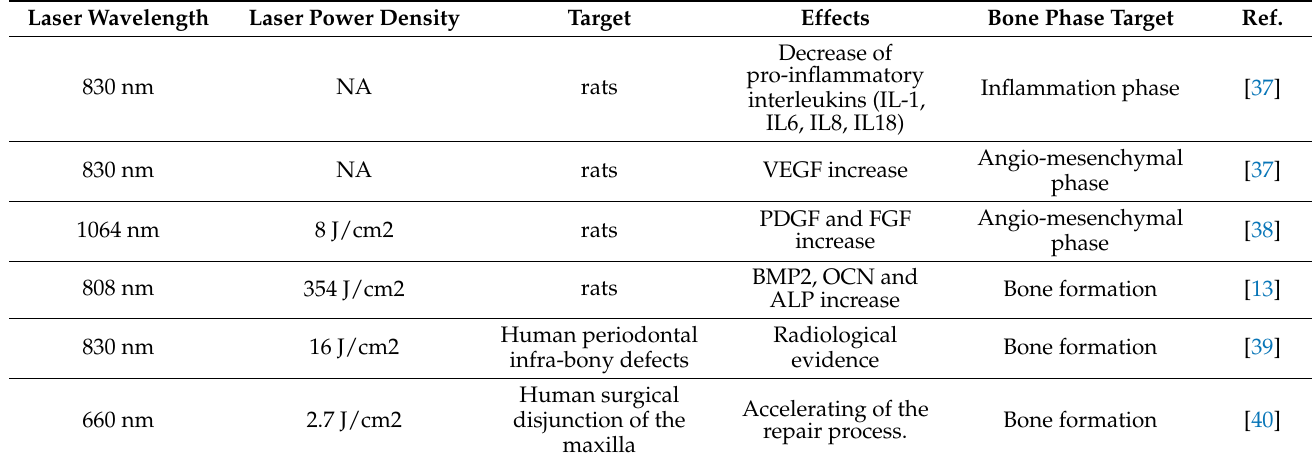
Table 3. Summary of in vivo LLLT